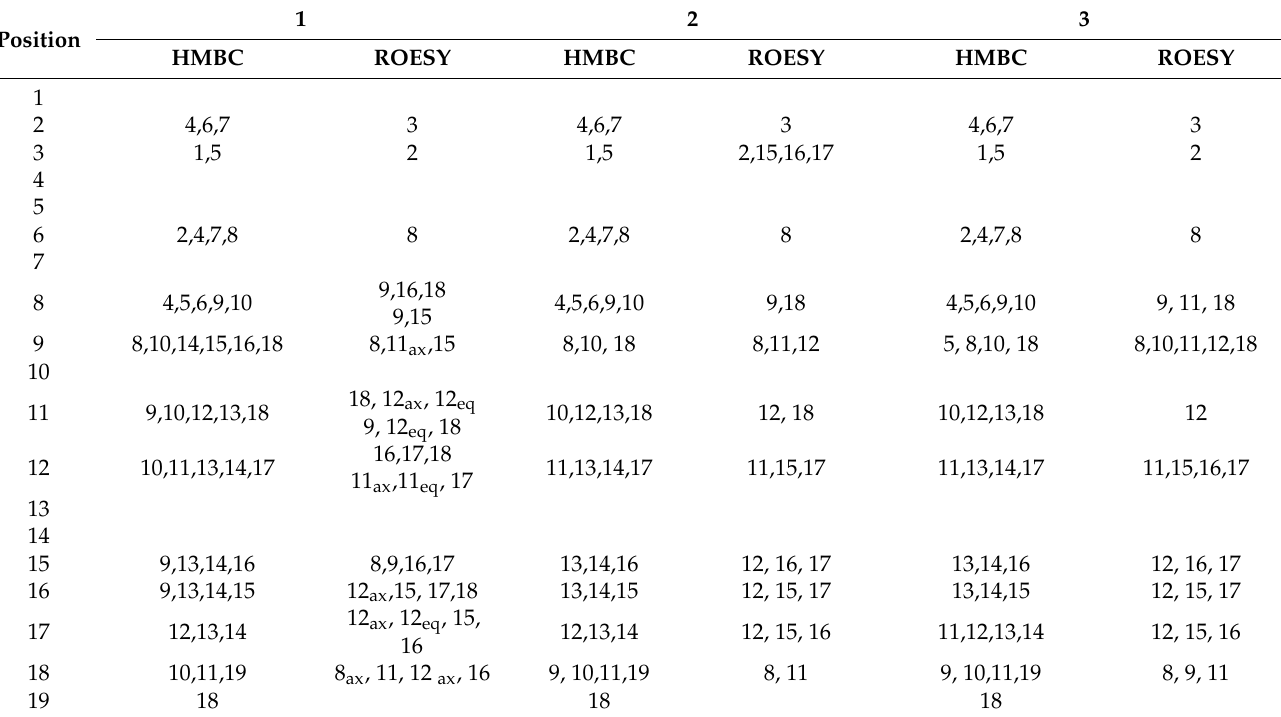
Table 2. The HMBC and ROESY correlations of compounds 1–3 (CD 3